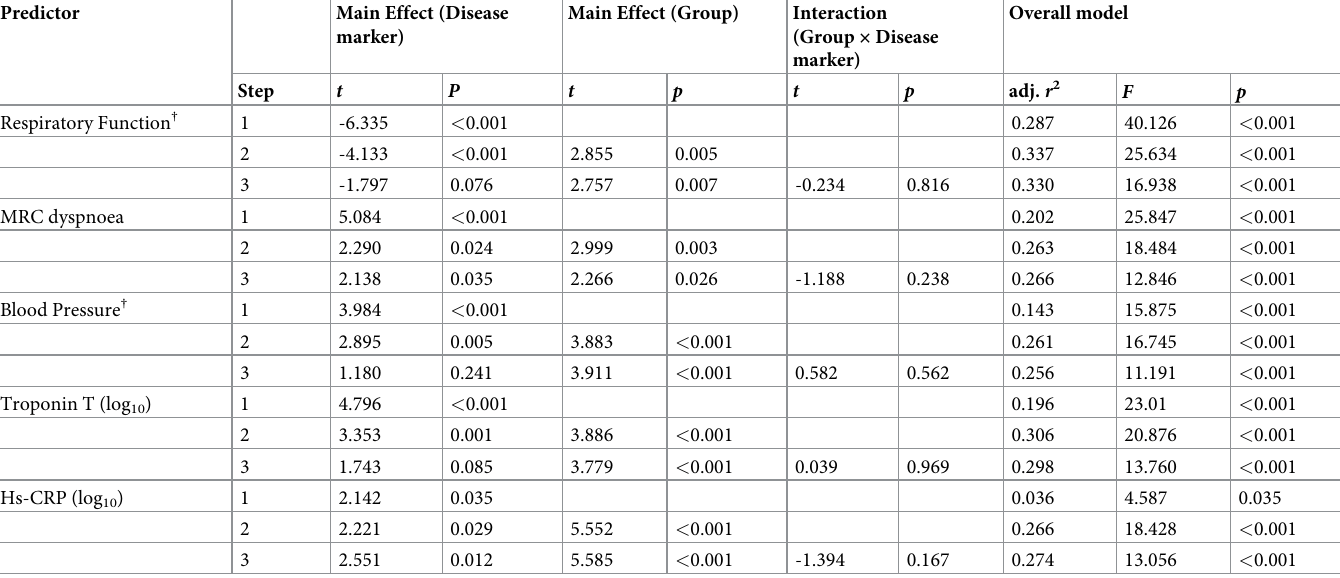
Three-step hierarchical linear model showing the relationship between White Matter Microstructure and disease markers. Step 1 predictors: disease marker only; Step 2 predictors: disease marker, group (Group); Step 3 predictors: disease marker, group, group × disease marker interaction. Reported are the t -statistics ( t ) and p -values for each main effect and interaction, as well as the regression coefficient ( r 2 ), adjusted regression coefficient (adj r 2 ), F -statistics ( F ) and p -values ( p ) for the overall models. The COPD > CAD contrast for the main effect of group and the group × disease marker interaction is shown. All models included a constant term (not shown). All variables were adjusted for age and sex. Hs-CRP = high-sensitivity C-Reactive Protein, MRC = Medical Research Council. † Principal